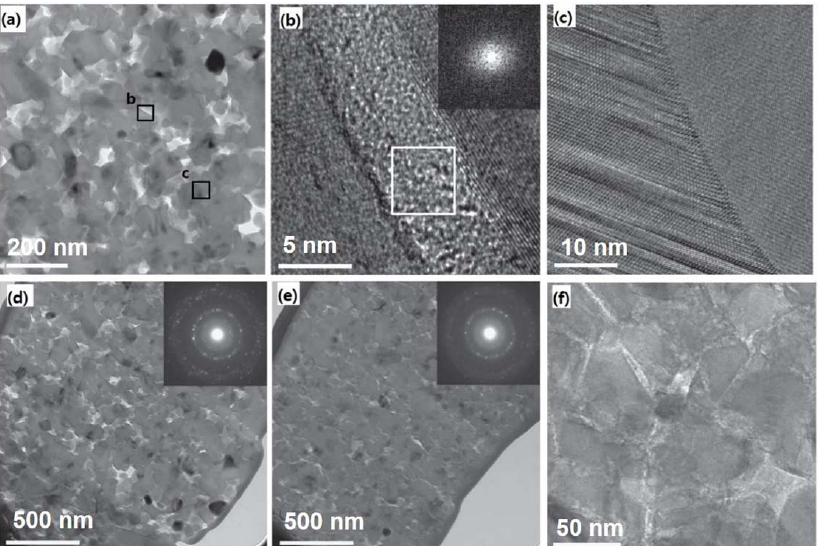
Figure 8. ( a ) TEM image of n-B 4 C showing homogeneously distributed nanopores (Figure 8b,c correspond to the respective boxes indicated in ( a )). ( b ) HRTEM image of GB showing the presence of amorphous carbon interface phase between two grains and the corresponding FFT pattern (given in the inset). ( c ) HRTEM image of clean GB showing absence of interface phase. ( d ) BF-TEM micrograph showing uniformly distributed pores in n-B 4 C under the undeformed region and the corresponding SAED pattern (given in the inset). ( e ) BF-TEM image showing densification of n-B 4 C under deformed region and the corresponding SAED pattern (given in the inset). ( f ) TEM micrograph showing well-distributed encapsulation of interface carbon around n-B 4 C grains. Reproduced with permission from [58]. Copyright 2022 Nature Communications.